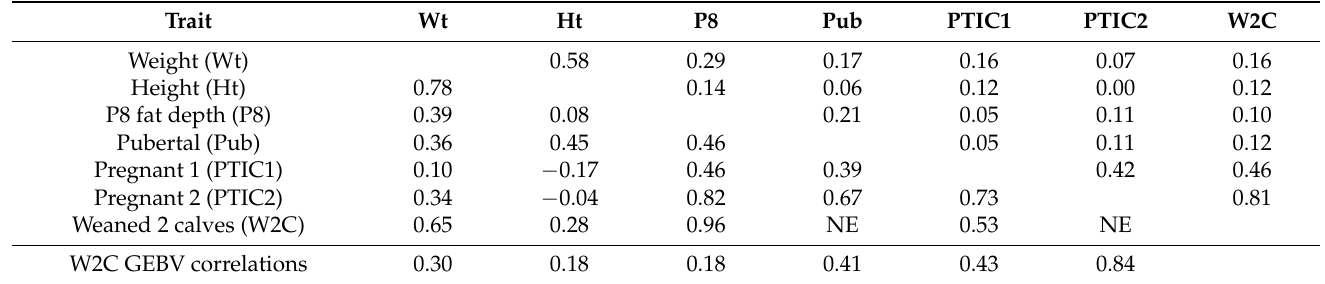
Table 3. Genetic (below diagonal) and phenotypic correlations between traits from bivariate analyses and correlations between GEBVs for weaned two calves from univariate analyses.